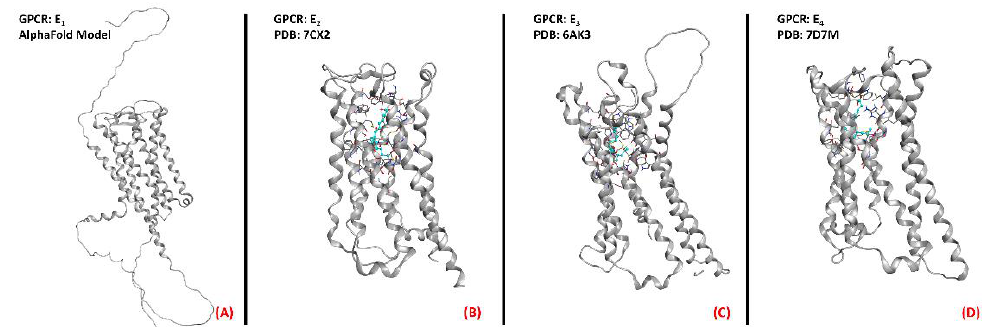
Figure 22. Structure ofthe PGE 2 receptors ( A ) EP 1 (with no experimentally resolved structure available, the model sourced from the AlphaFold database is presented), ( B ) EP 2 (sourced from the Protein Data Bank, PDB code: 7CX2 [149], method: cryo-EM, resolution: 2.80 Å ), ( C ) EP 3 (sourced from the Protein Data Bank, PDB code: 6AK3 [150], method: X-ray diffraction, resolution: 2.90 Å ), and ( D ) EP 4 (sourced from the Protein Data Bank, PDB code: 7D7M [151], method: cryo-EM, resolution: 3.30 Å ). All of the images were created and rendered with MOE.